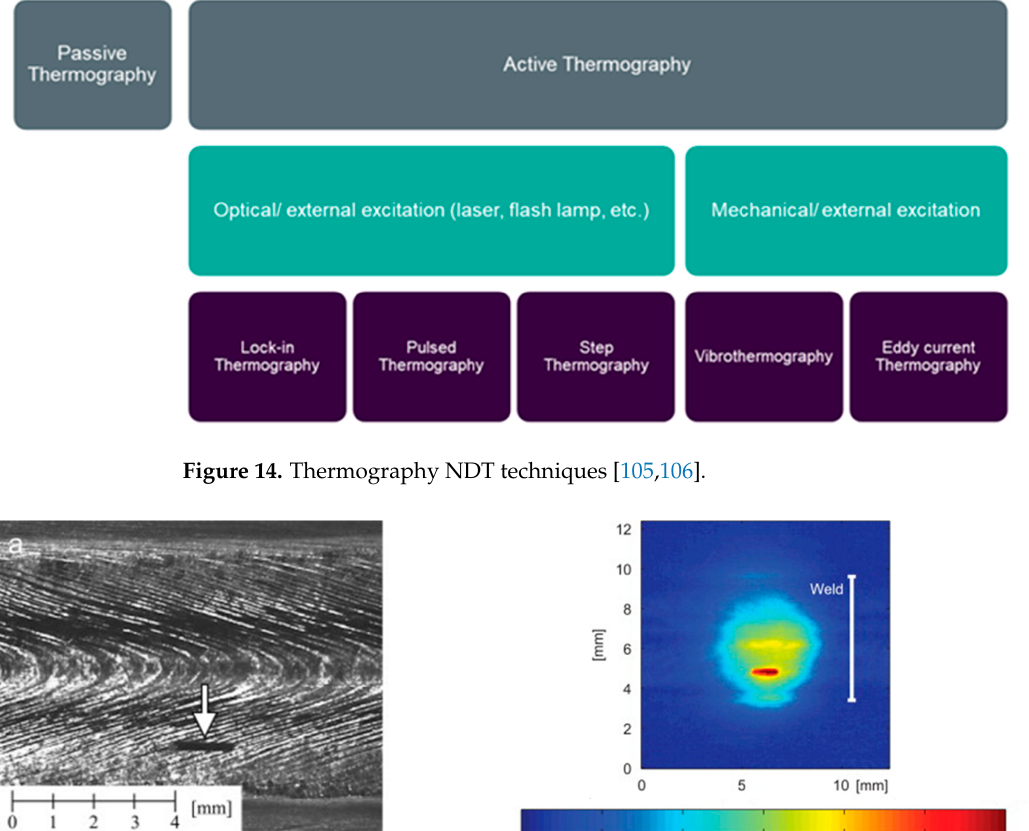
Figure 14. Thermography NDT techniques [105,106].